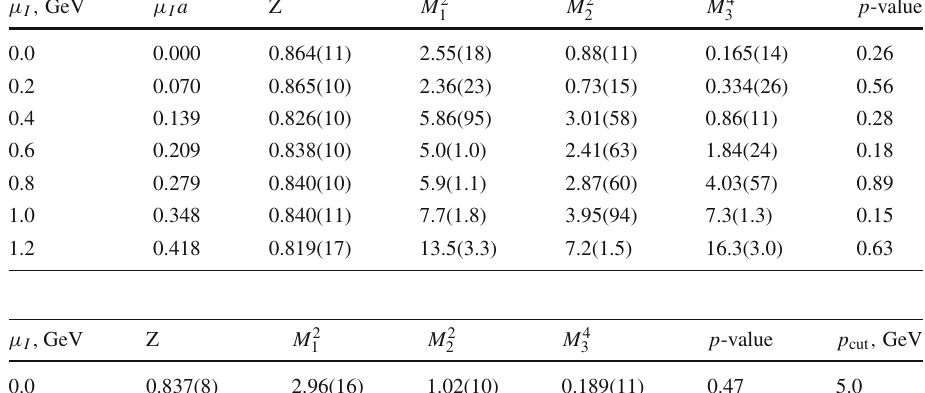
parameters of the Gribov–Stingl fit (23) for the transverse propagator D T ( p 2 )